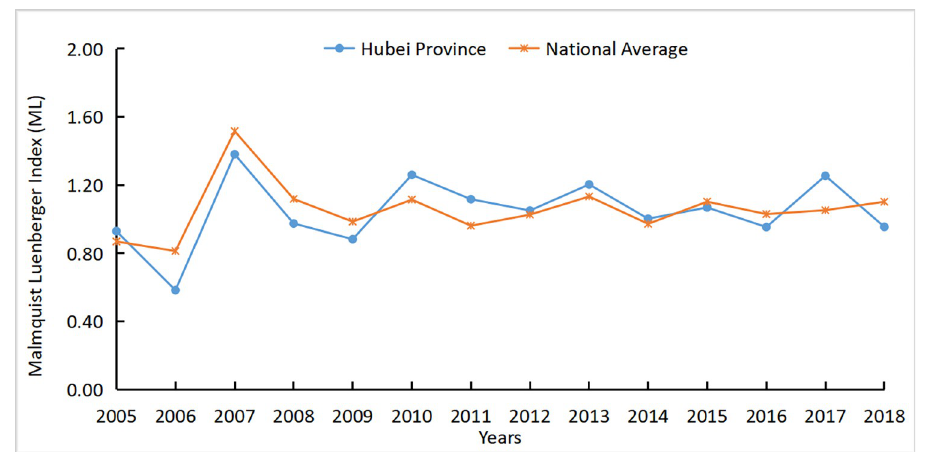
Fig 5. ML index of Hubei Province and national average from 2004 to 2018.